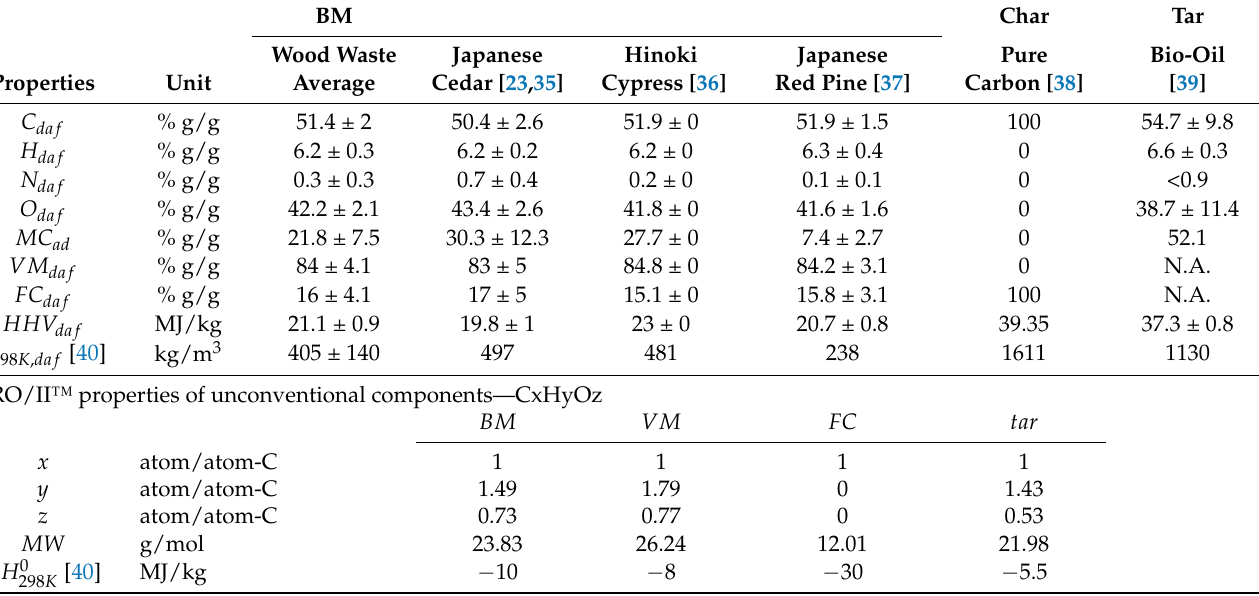
Table 1. Thermochemical properties of non-conventional components: biomass, char, and tar. N.A. means not applicable. BM Char Tar Wood Waste